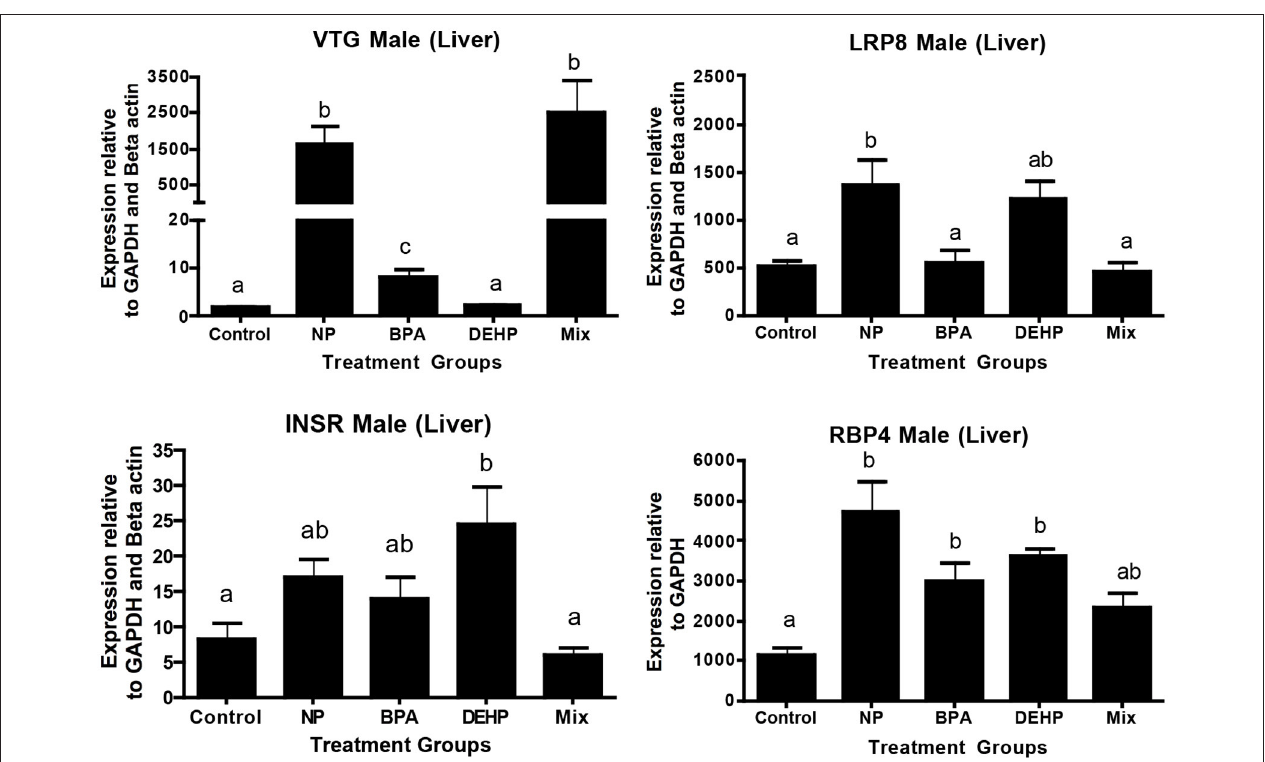
FIGURE 4 | Validation of expression microarray results by quantitative real-time PCR (qPCR). Effects of 100 µ g/L of NP, BPA, DEHP and the mixture of three chemicals on genes involved in lipid metabolism and transportation following 21 days exposure. The expression levels were measured using qPCR and normalized against the mean of GAPDH and β -actin (mean ± SEM). Different letters indicate a significant difference (ANOVA followed by Tukey Test, P < 0.05, n =